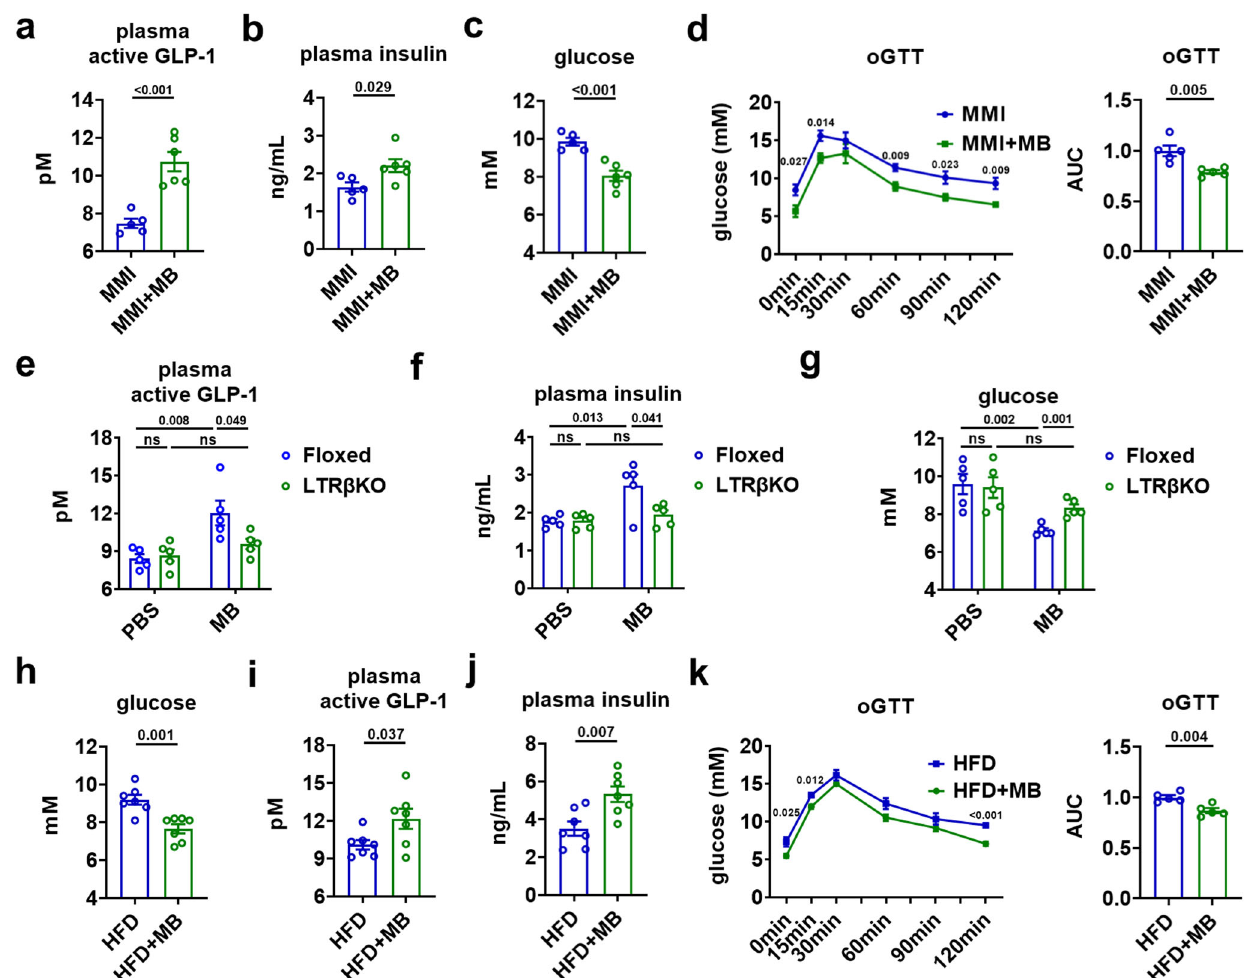
Fig. 3 | Pharmacological activation of the hepatic TR β potentiates the GLP-1 production. a – c Plasma active GLP-1 ( a ), plasma insulin ( b ), and blood glucose ( c ) levels in MMI mice and MMI mice treated with MB for 5 days ( n =5 – 6). d oGTT for MMI mice and MMI mice treated with MB for 5 days (left) and the AUC for oGTT (right)( n =5). e – g PlasmaactiveGLP-1 ( e ),plasmainsulin ( f ),and blood glucose ( g ) levels in Floxed and LTR β KO mice treated with PBS or MB for 5 days as indicated